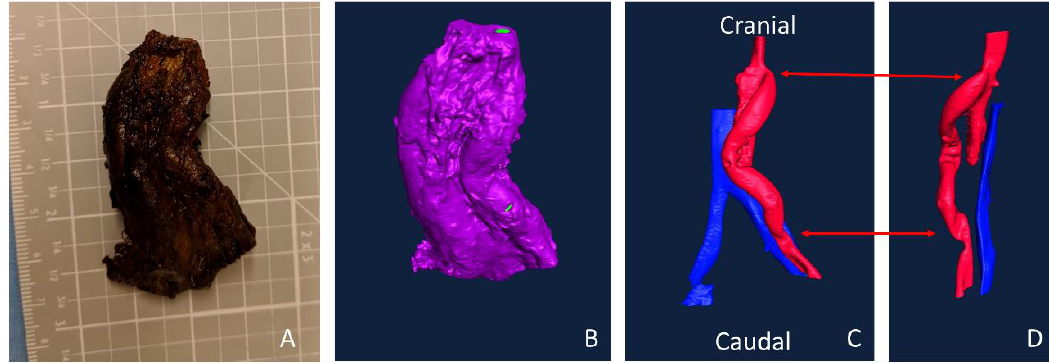
Figure 9. Explanted aorto-iliac bypass sample after 28-day implant. The ePTFE sample was implanted on the right side, and after Lugol’s soaking ( A ), the surrounding tissue was rendered radiopaque. After microCT imaging and Amira surface rendering ( B ), open lumens were selected. The aorta and graft, in red, show the branching from the abdominal aorta to the iliac artery ( C,D ). The aorta is tied o ff and stops in ( D ) but would follow a similar anatomical path—parallel to the vein (blue), which was unaltered during surgery. Arrows indicate the position of the anastomoses: proximal at the top / cranial, distal at the bottom /